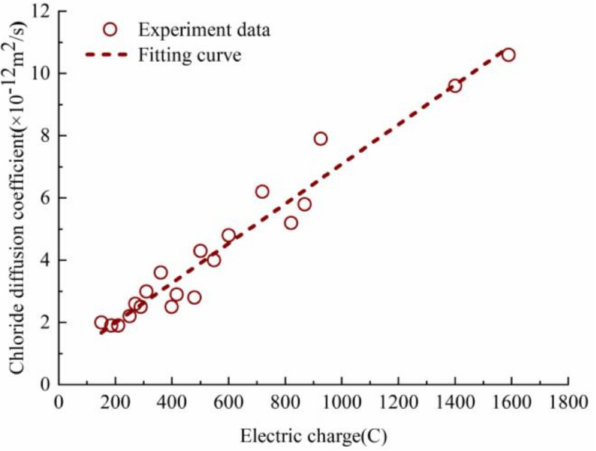
Figure 10. The Variation of chloride ion di ff usion coe ffi cient with